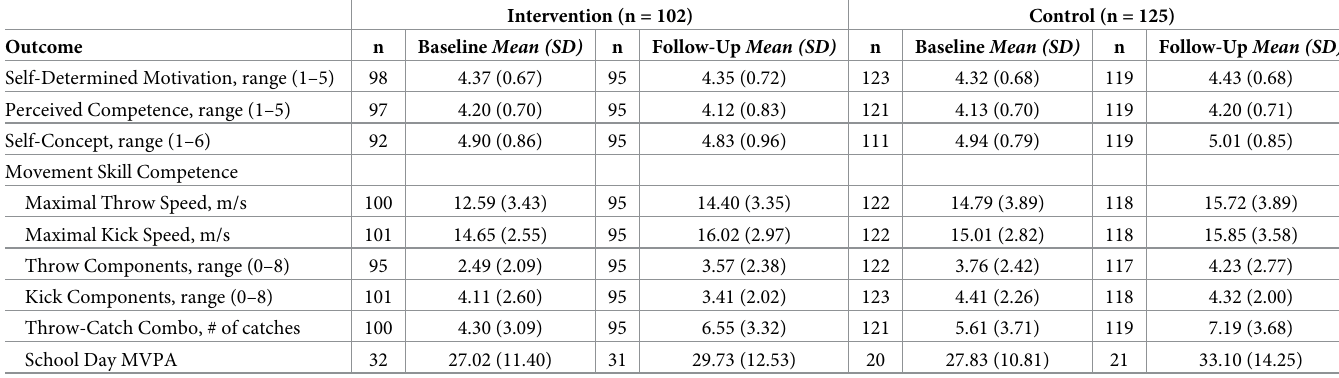
Table 2. Grade 3/4 student outcomes at baseline and